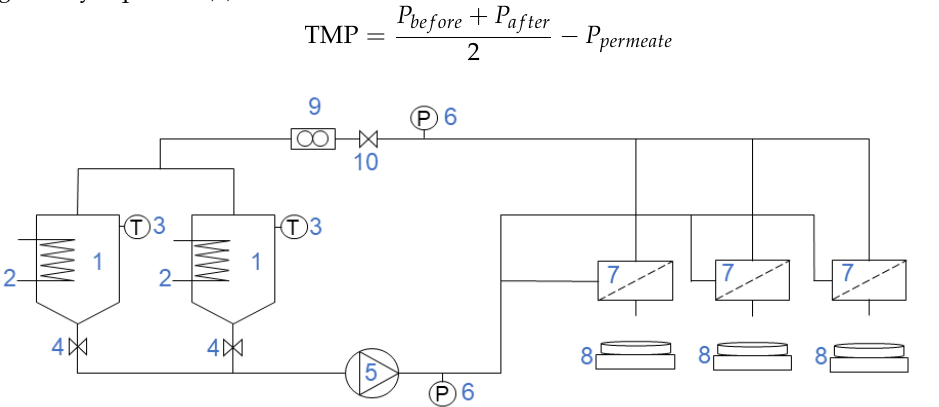
Figure 1. Experimental setup consisting of (1) tanks, (2) electric heaters, (3) temperature sensors, (4) valves, (5) feed pump, (6) manometers, (7) membrane modules for flat-sheet membranes, (8) digital scales, (9) flowmeter, and (10) retentate valve.